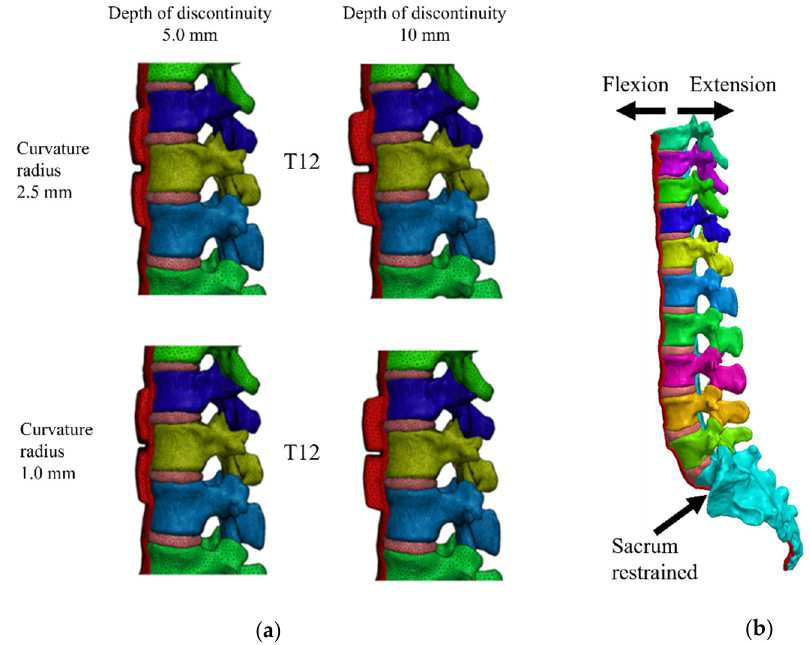
Figure 4. Ossifying hypertrophic grooves at 5 ( a ) and 10 mm ( b ) were created at T11–T12 and T12–L1. In these diffuse idiopathic skeletal hyperostosis models, the sacrum was fixed and the cranial endplate of T8 was displaced in the direction of flexion and extension.